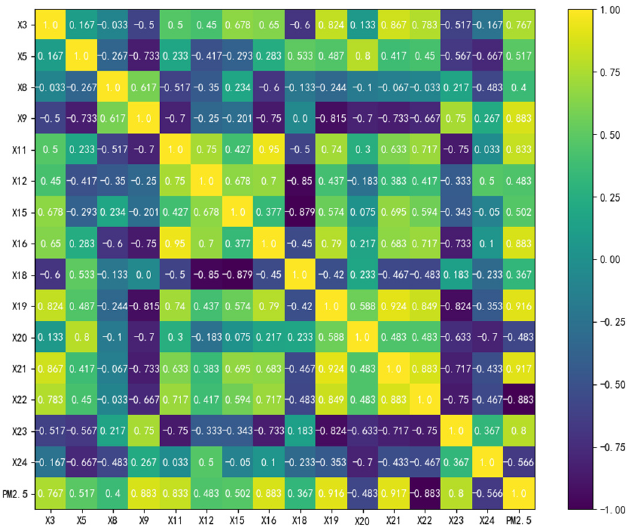
Figure 5. The SC correlation analysis results of APIIU of PM 2.5 .